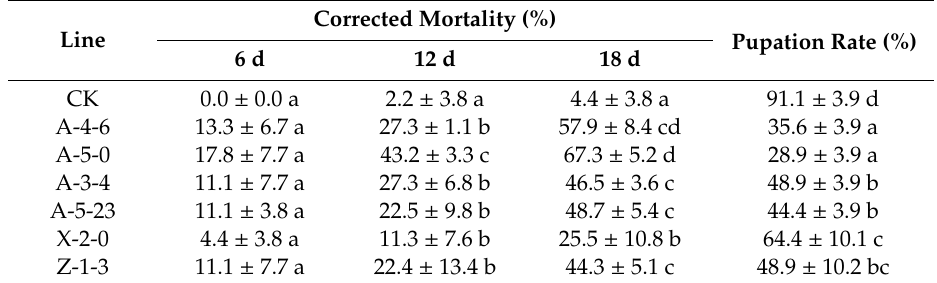
Table 1. Insecticidal activity of Bacillus thuringiensis ( Bt ) transgenic poplar against Hyphantria cunea . Line